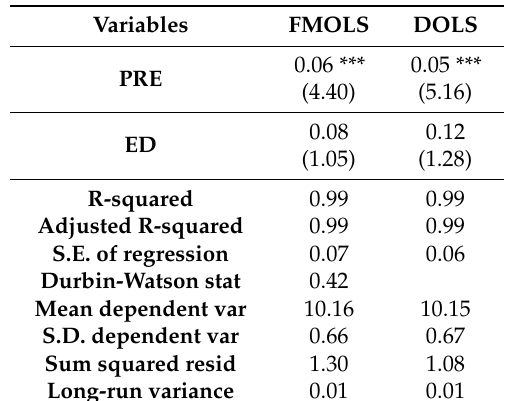
Table 12. Ouput of panel fully modified OLS (FMOLS) and dynamic OLS